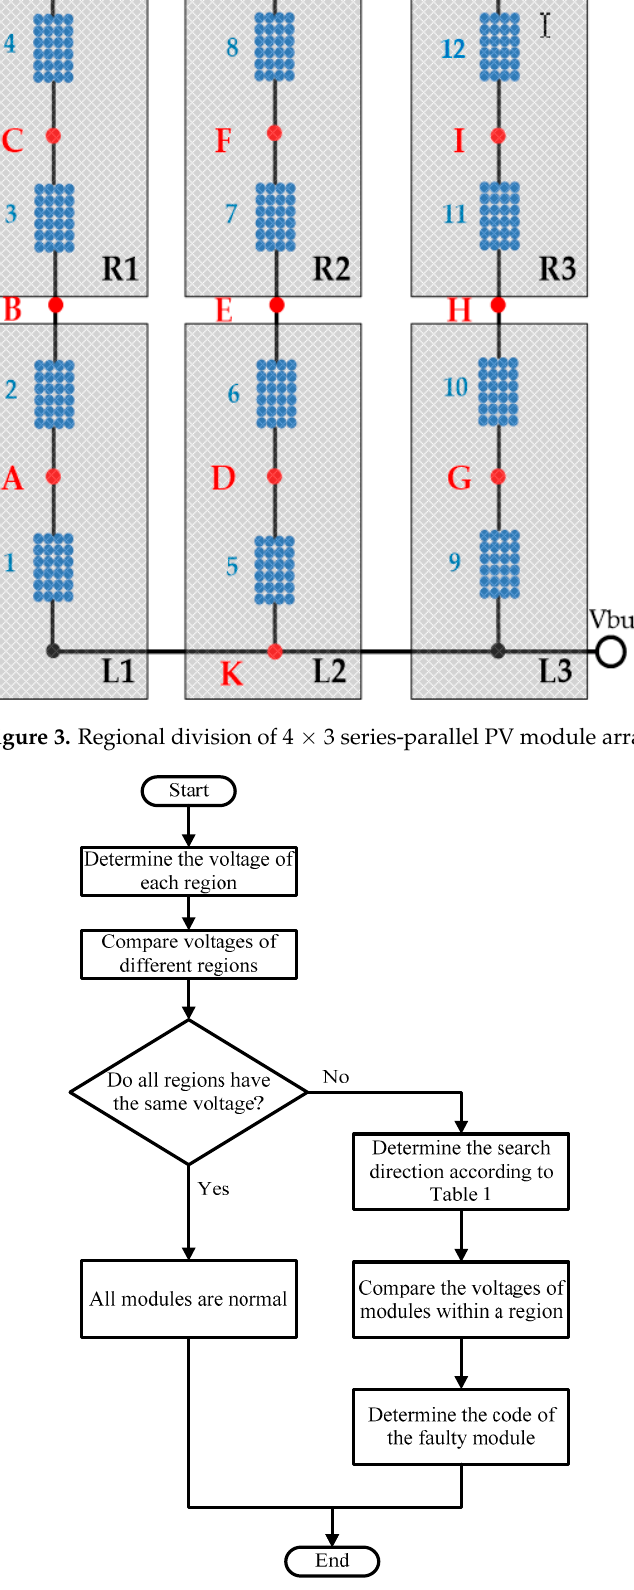
Figure 4. Flow chart of binary search algorithm .